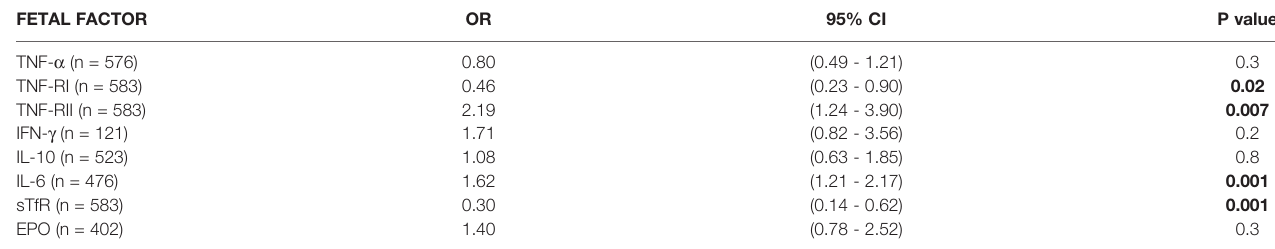
Bold values represent signi fi cant